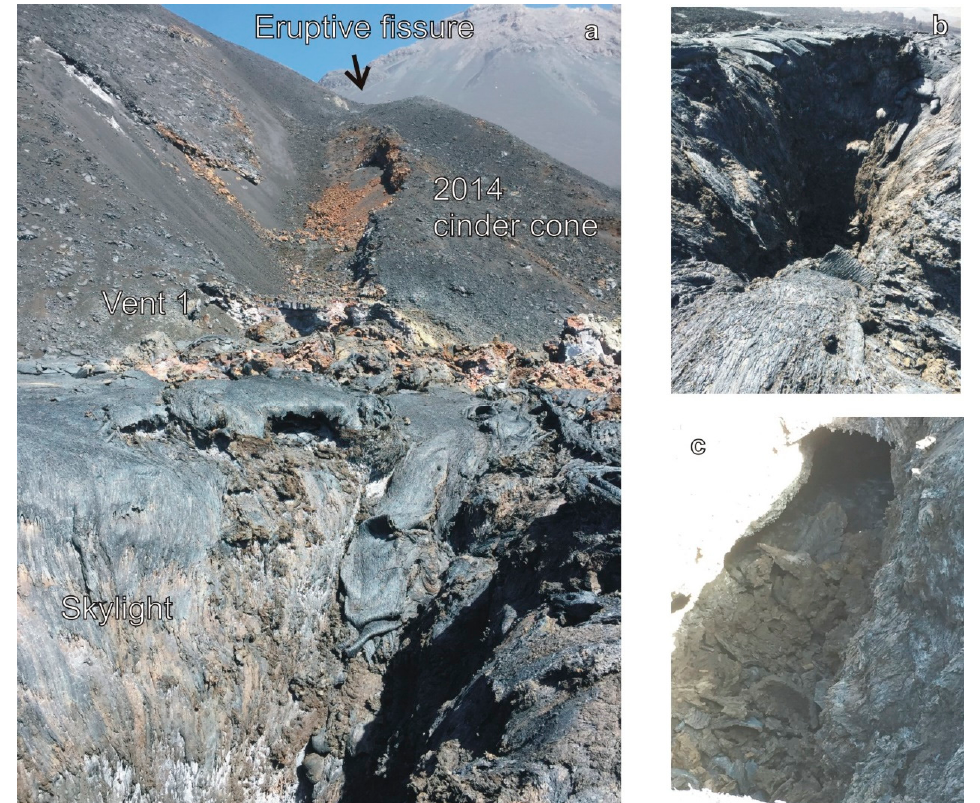
Figure 4. Photos of Fogo: ( a ) The 2014 eruptive fissure and cinder cone, taken from West on 23 November 2015, with at its base a frozen lava pond where Vent 1 was located. In the foreground is a skylight with a tube (visible in c) at its base, about 20 m below the surface. Pico do Fogo is in the background. ( b ) View of the skylight as taken from east and looking down flow, with the pahoehoe surface coating the inner walls of the skylight, displaying final drainage of lava within the depression. ( c ) Lava tube, about 2–3 m wide, at the bottom of the skylight shown in a and b .